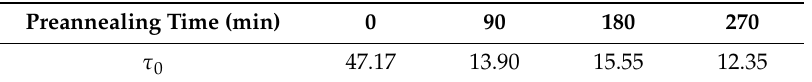
Table 1. Summary of exponential fitting parameter τ 0 with di ff erent preannealing times.